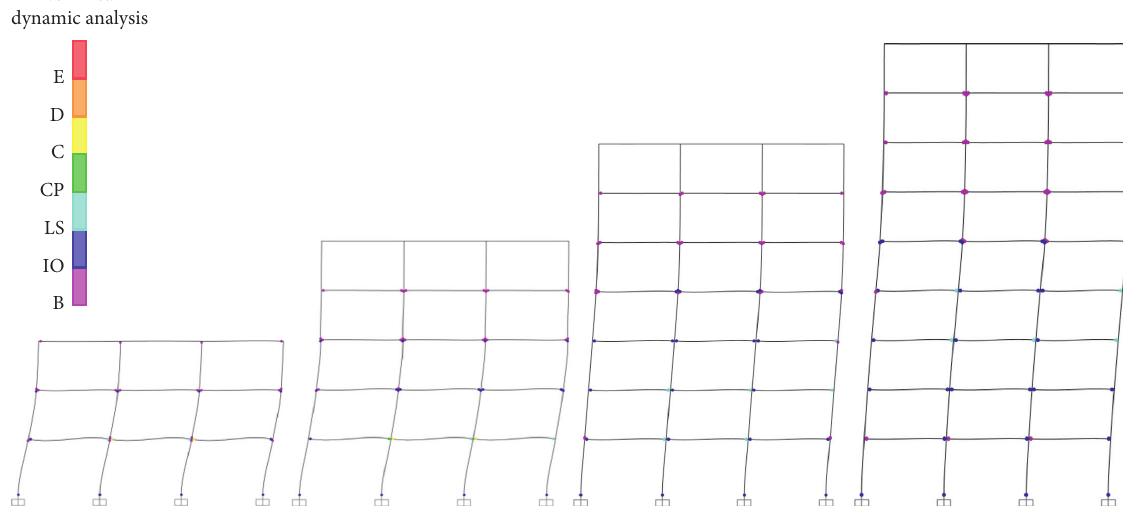
Figure 9: Distribution of plastic hinges. Nonlinear dynamic analysis of 3-bay RC frames under the Bevagna